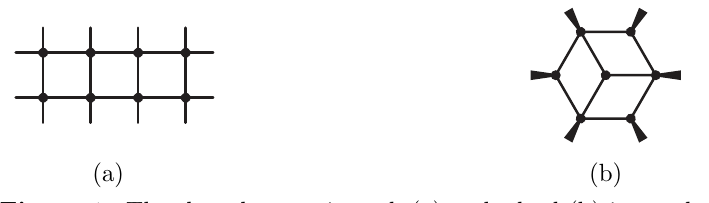
Figure 1. The three-loop traintrack (a) and wheel (b)